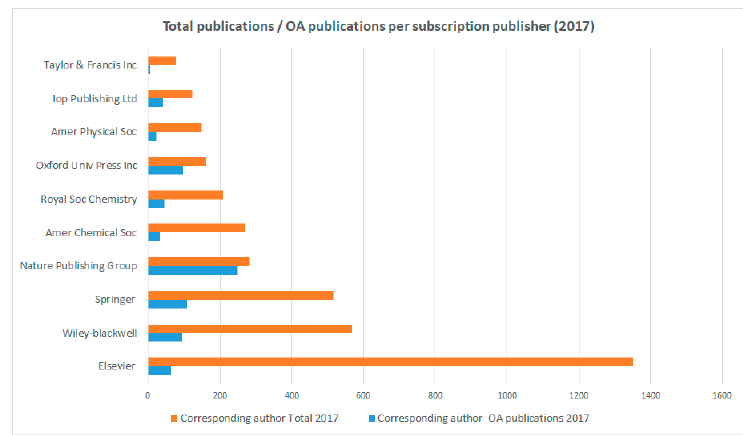
Figure 12. Total publications versus total OA publications, distributed by subscribed publisher.